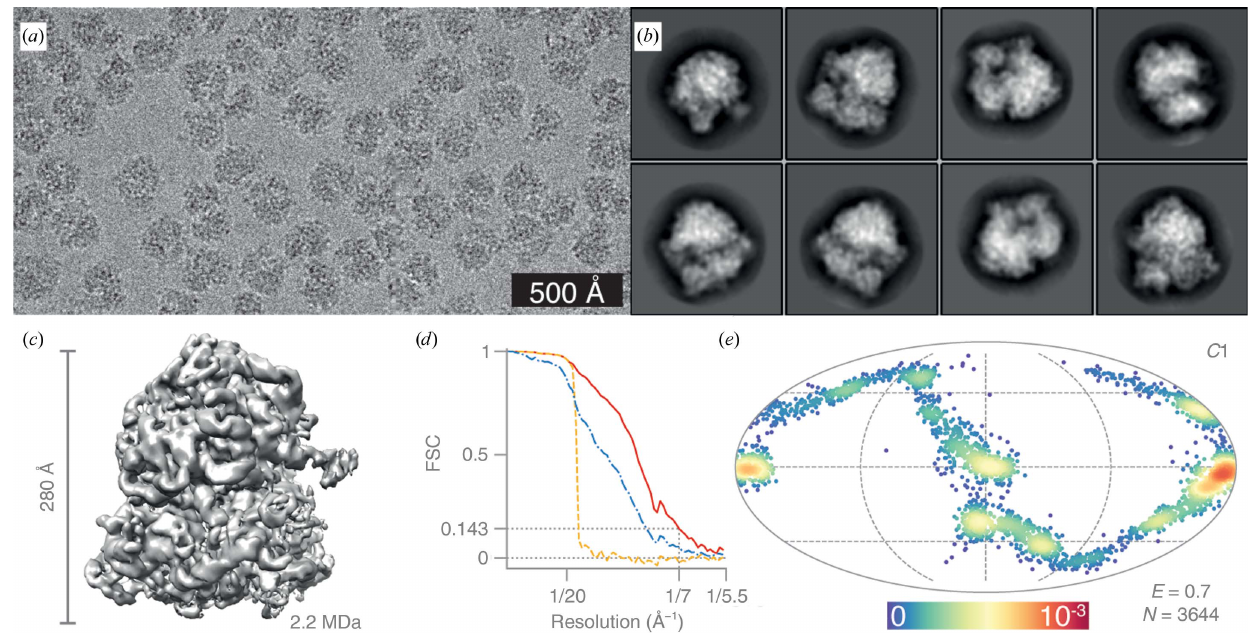
Figure 8 Structure of the E. coli 70S ribosome determined at 100 keV. ( a ) Typical micrograph after motion correction. Contrast is adjusted to (cid:8) 3 (cid:3) from the mean intensity. ( b ) 2D class averages. ( c ) Sharpened masked 3D reconstruction of the 70S ribosome from N = 3644 particles without symmetry ( C 1). ( d ) Gold- standard FSC plot corresponding to the calculated map, showing the correlation between the phase-randomized (yellow), unmasked (blue) and masked (red) half-maps. The plot terminates at the Nyquist frequency. ( e ) Orientation distribution of the 70S ribosomes contributing to the final reconstruction (Mollweide projection). The colour scale (linear) corresponds to the normalized density of views (blue, low; red, high). E = 0.7 is the efficiency of the orientation